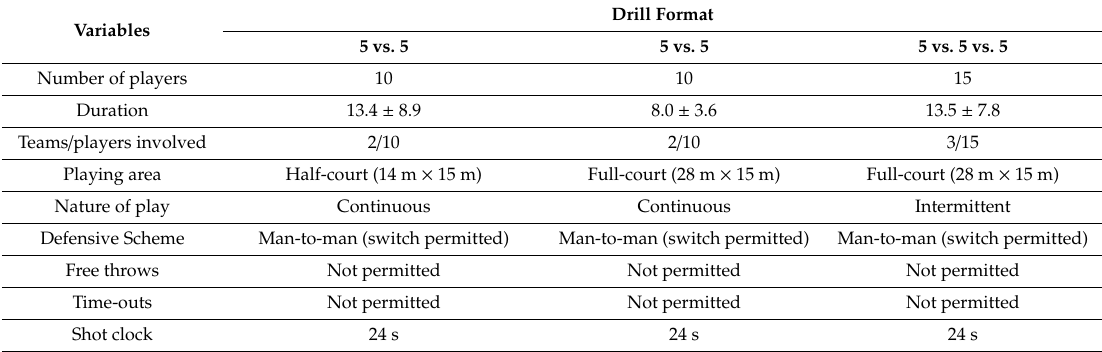
Table 1. The format, rules and conditions used in each games-based